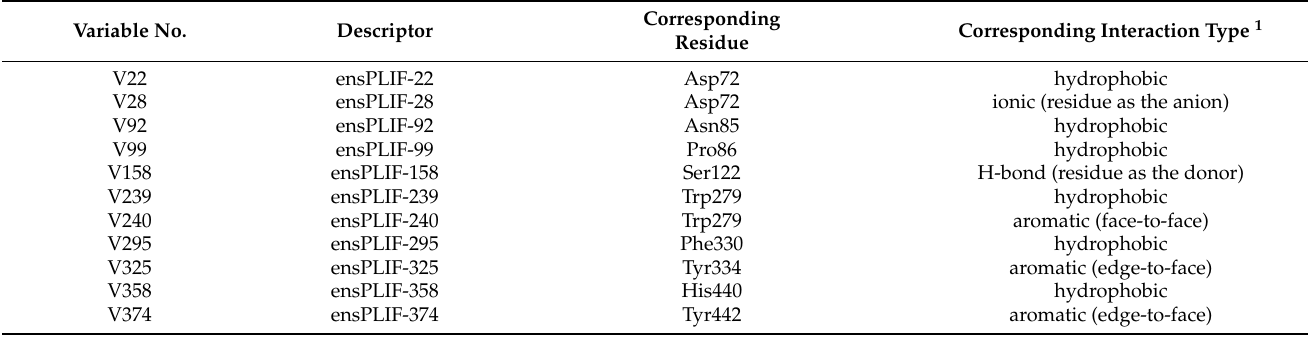
Table 1. The ensPLIF descriptors in the decision tree resulted from the RPART run with the prior probabilities of 0.9:0.1.